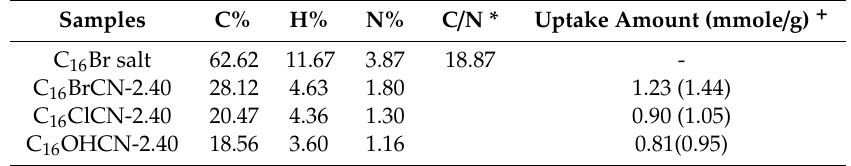
Table 1. CHN elemental analysis of di ff erent OCs prepared from di ff erent